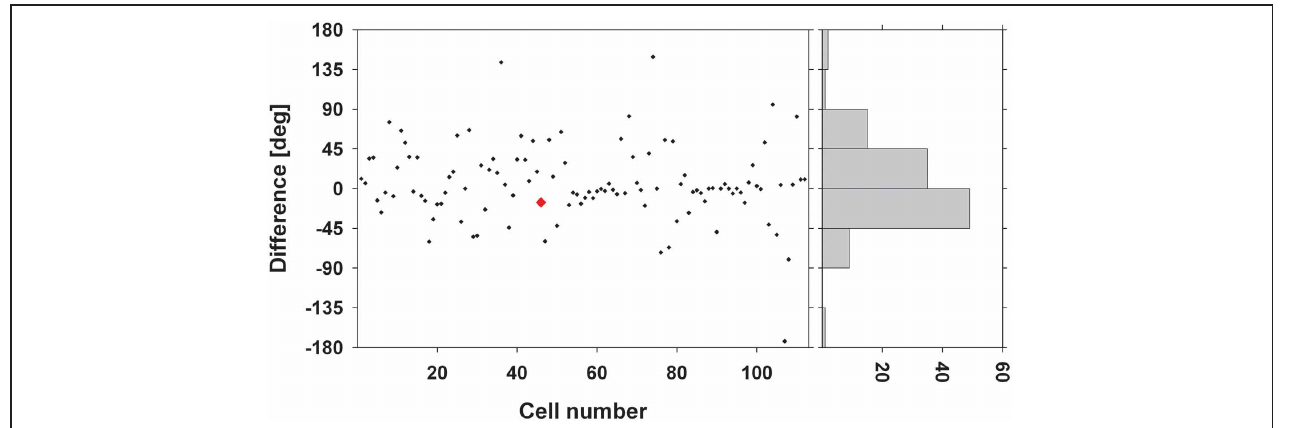
disparity tuning was shown in Figures 3 and 6 . The histogram on the right gives the distribution of these angular differences sorted in 45 ◦ bins. Seventy-five percent of the cells showed a mean angular difference of less than ± 45 ◦ .